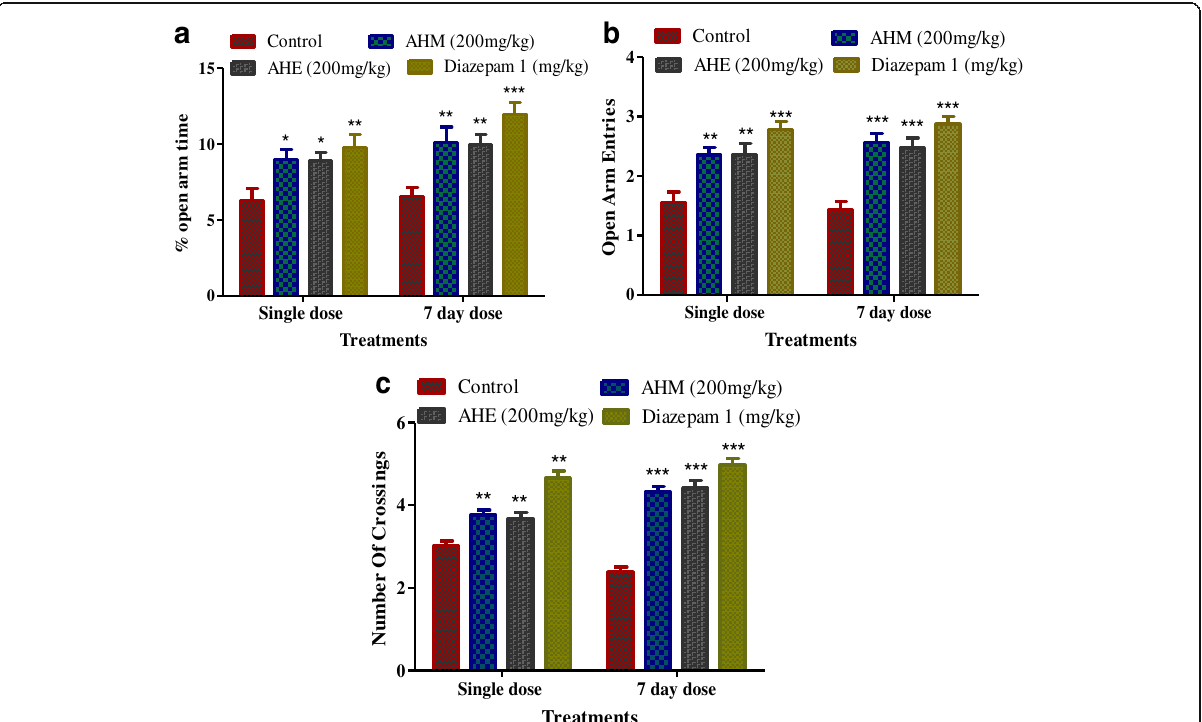
Fig. 4 Effects of the acute and repeated dose of AHM and AHE in the elevated plus-maze test on the percentage of the time spent in the open arms ( a ), the number of open-arm entries ( b ) and the number of crossing ( c ) in depressed rats. Values are means + SEM ( n = 6). Data analyzed by one way ANOVA followed by Tukey ’ s multiple comparison tests